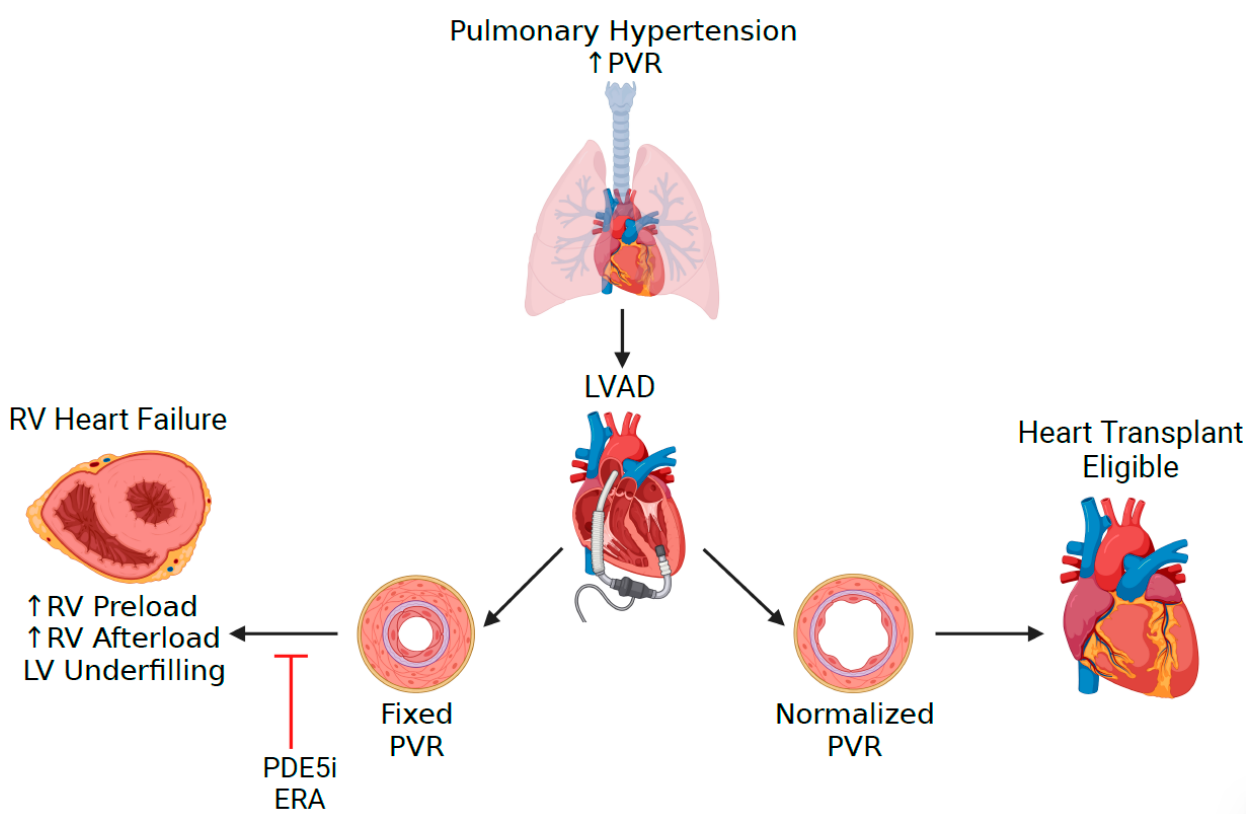
Figure 3. LVAD effect on pulmonary vasculature. Reduction in PVR increases heart transplant probability while persistent PVR elevation is associated with RV failure. ERA: endothelin receptor antagonists; LV: left ventricle; LVAD: left ventricular assist device; PDE5i: phosphodiesterase 5 inhibitors; PVR: pulmonary vascular resistance; RV: right ventricle.